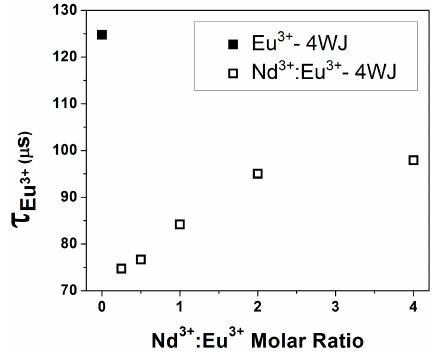
Figure 6. The addition of Nd 3+ quenched Eu 3+ –4WJ luminescence because of energy transfer. Increasing concentrations of Nd 3+ displaced Eu 3+ from the junction leading to a longer lifetime that approached the Eu 3+ lifetime observed in the absence of junction and Nd 3+ (111.9 ± 0.4 μ s). The Eu 3+ concentration was 64 μ M, while the concentration of junction was 6.3 μ M. Other conditions were as described in Figure 5.